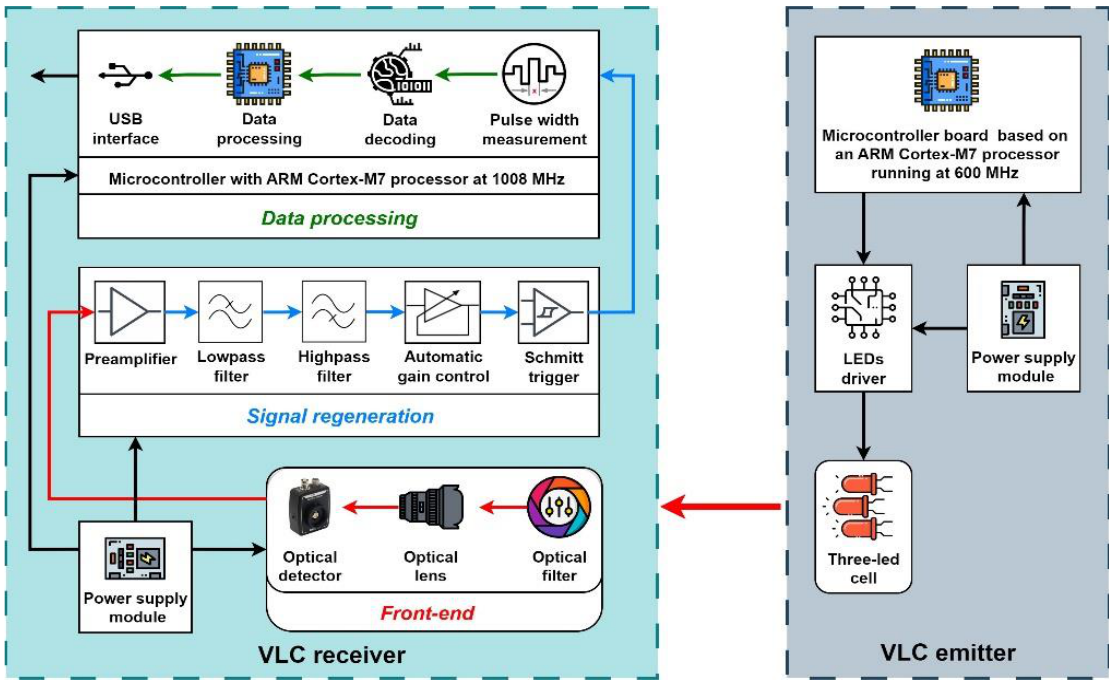
Figure 5. Schematic representation of the VLC prototype system used for the range extension ex- periments.